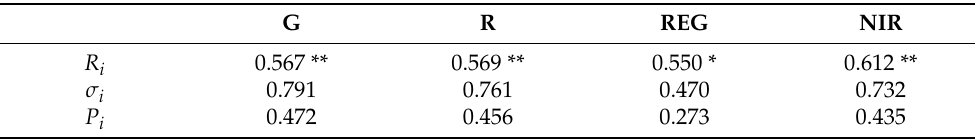
Table 5. Diagnostic index of UAV image reflectance.